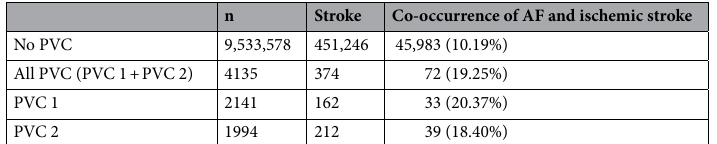
n Stroke Co-occurrence of AF and ischemic stroke No